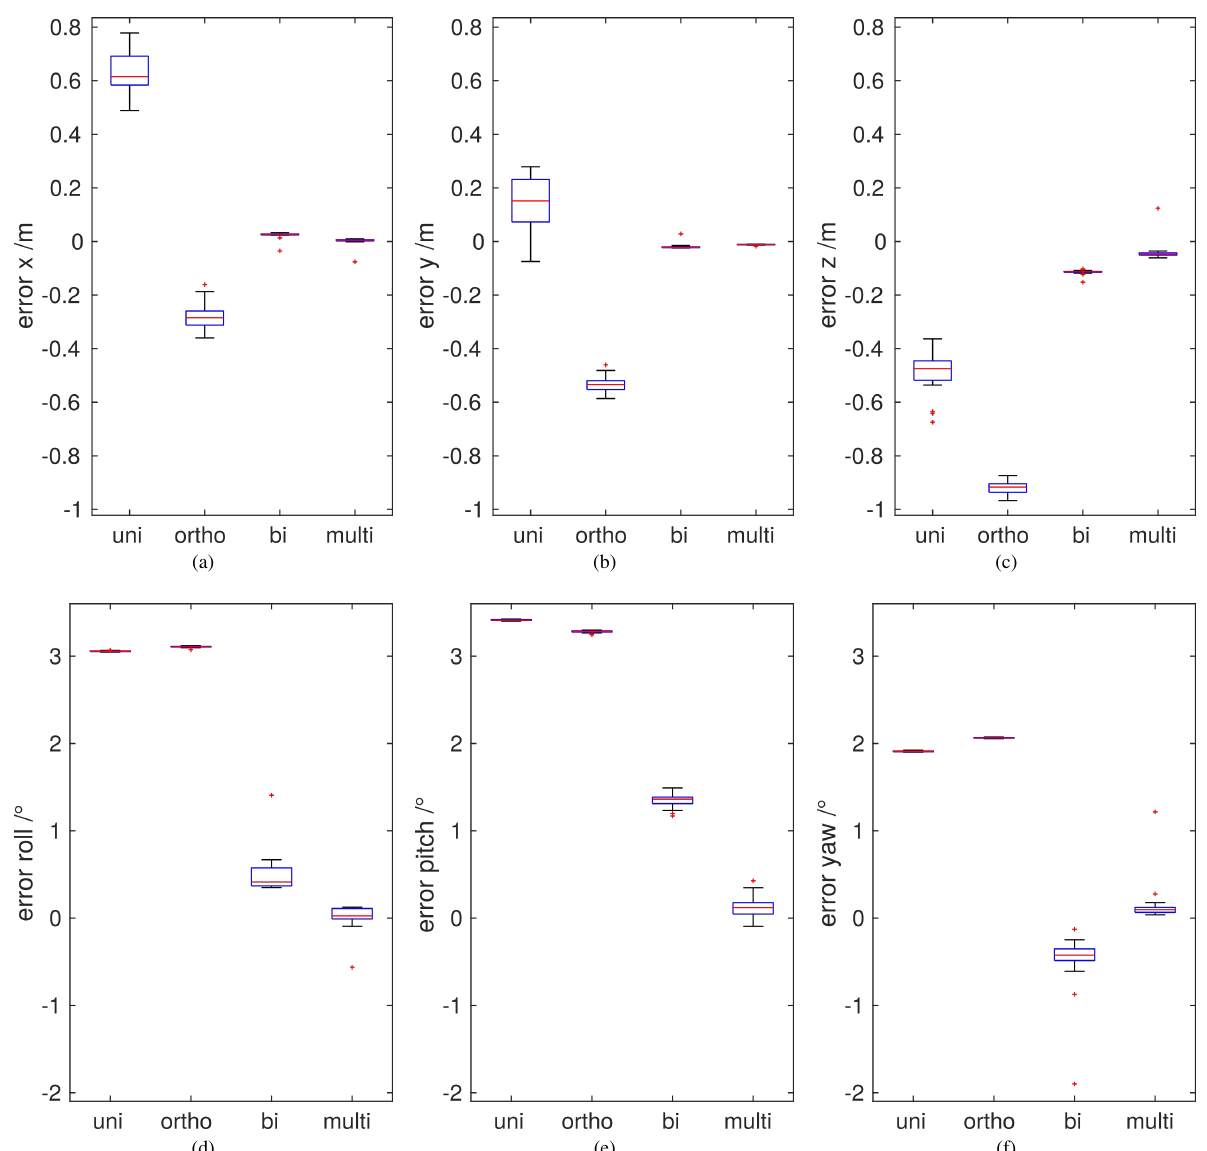
Figure 3. Calibration results for the relative translation parameters (a-c) and the relative rotation parameters (d-f) based on the four different investigated trajectories. The approximate parameters of the relative orientation before calibration are x 0 = y 0 = z 0 = 1 m = yaw = 3 ◦ and roll 0 = pitch 0 0